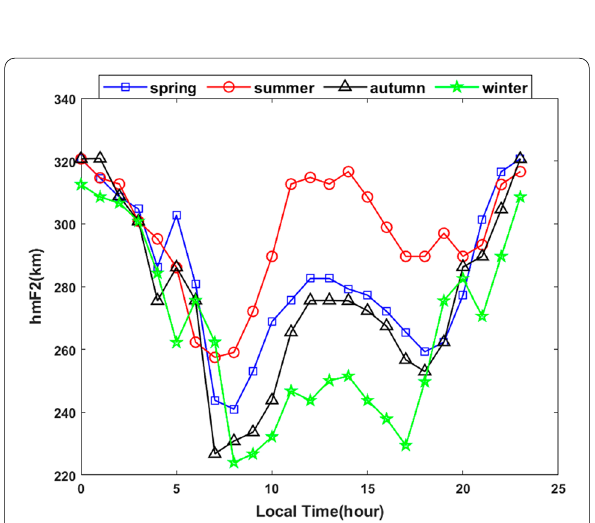
Fig. 11 A typical set of oblique-incidence F2-layer traces at 12:50 LT in summer and spring, the F2-layer trace circled by a red ellipse was taken on August 7, 2010, and the trace circled by a white ellipse was taken on March 7,